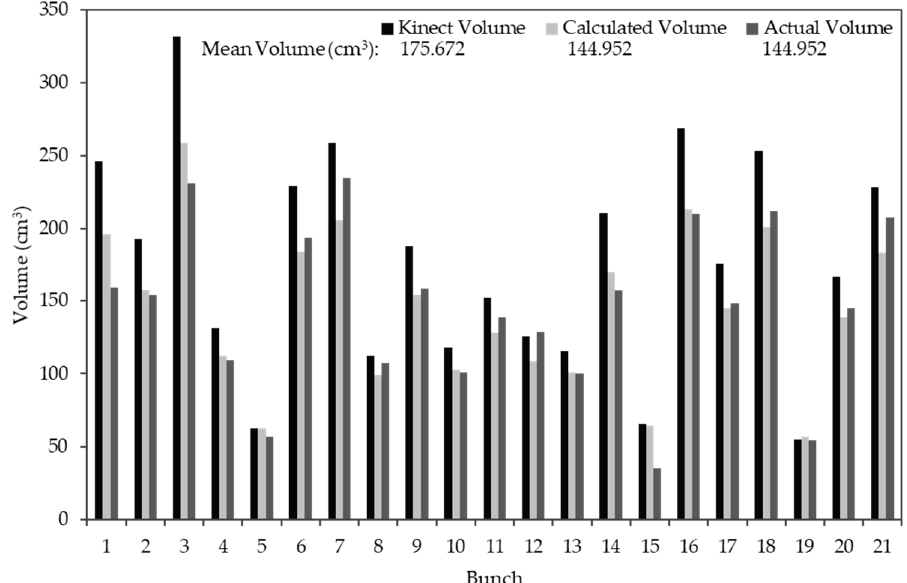
Figure 11. Experiment one’s results, for the 21 individual bunches, illustrating the volume estimation error by the Kinect sensor. error by the Kinect